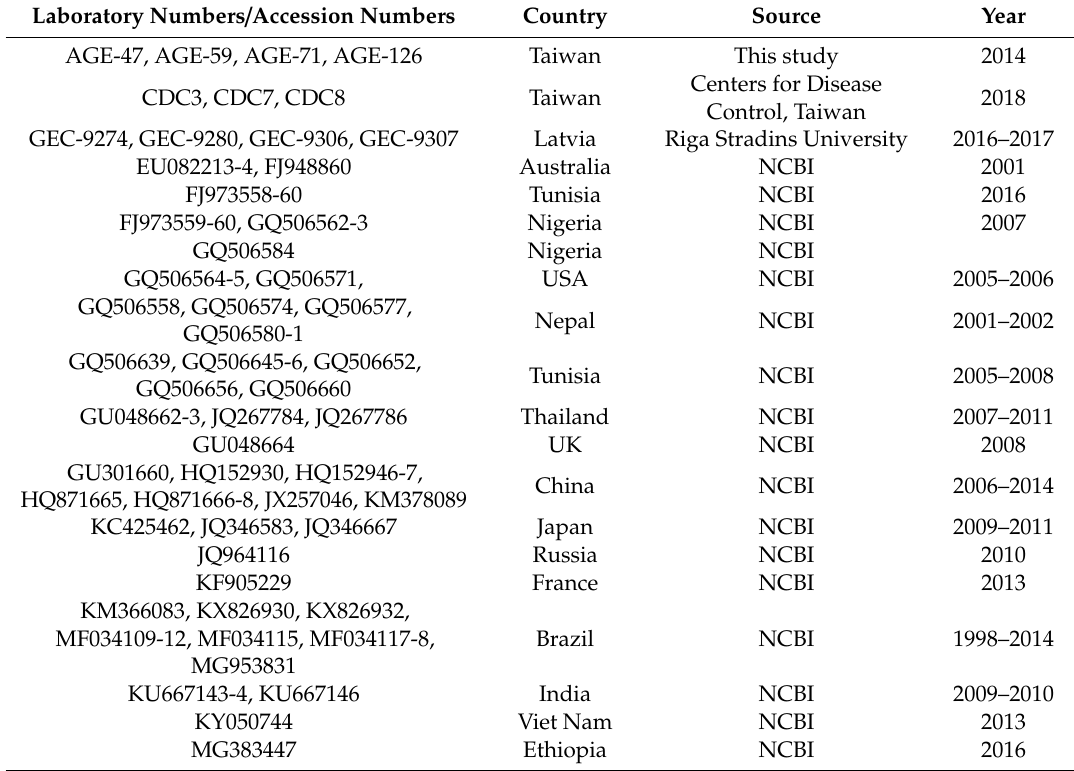
Table 1. Sequences list of the VP1 region of the human bocavirus 2 (HBoV2) used in this